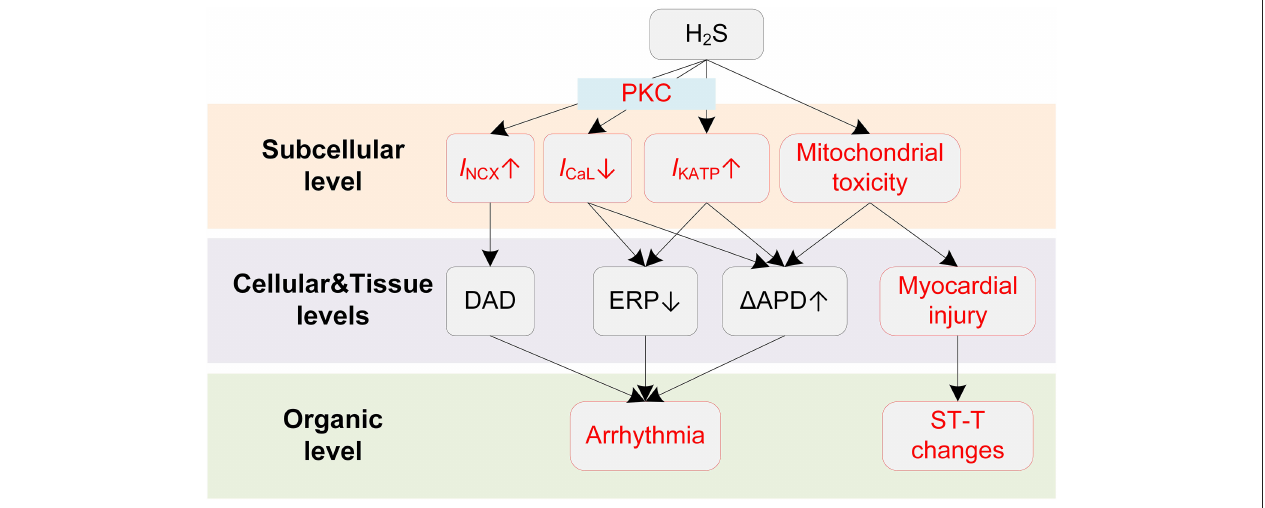
FIGURE 4 | Potential mechanisms underlying H 2 S-induced arrhythmias. Red boxes indicate effects of H 2 S that have been explicitly